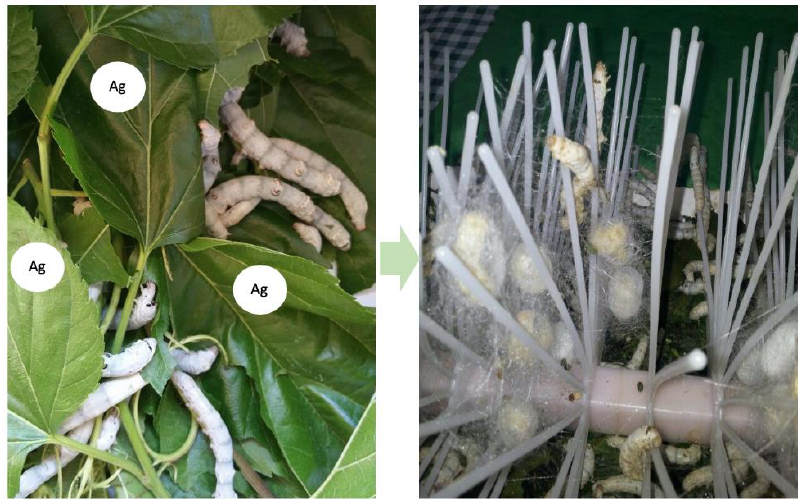
Figure 4. Representative pictures describing a method for obtaining intrinsically antibacterial silk fibroin. Silkworms fed on silver modified diet ( left ) produce silver doped cocoons ( right ) which can be processed to develop products with antibacterial properties.